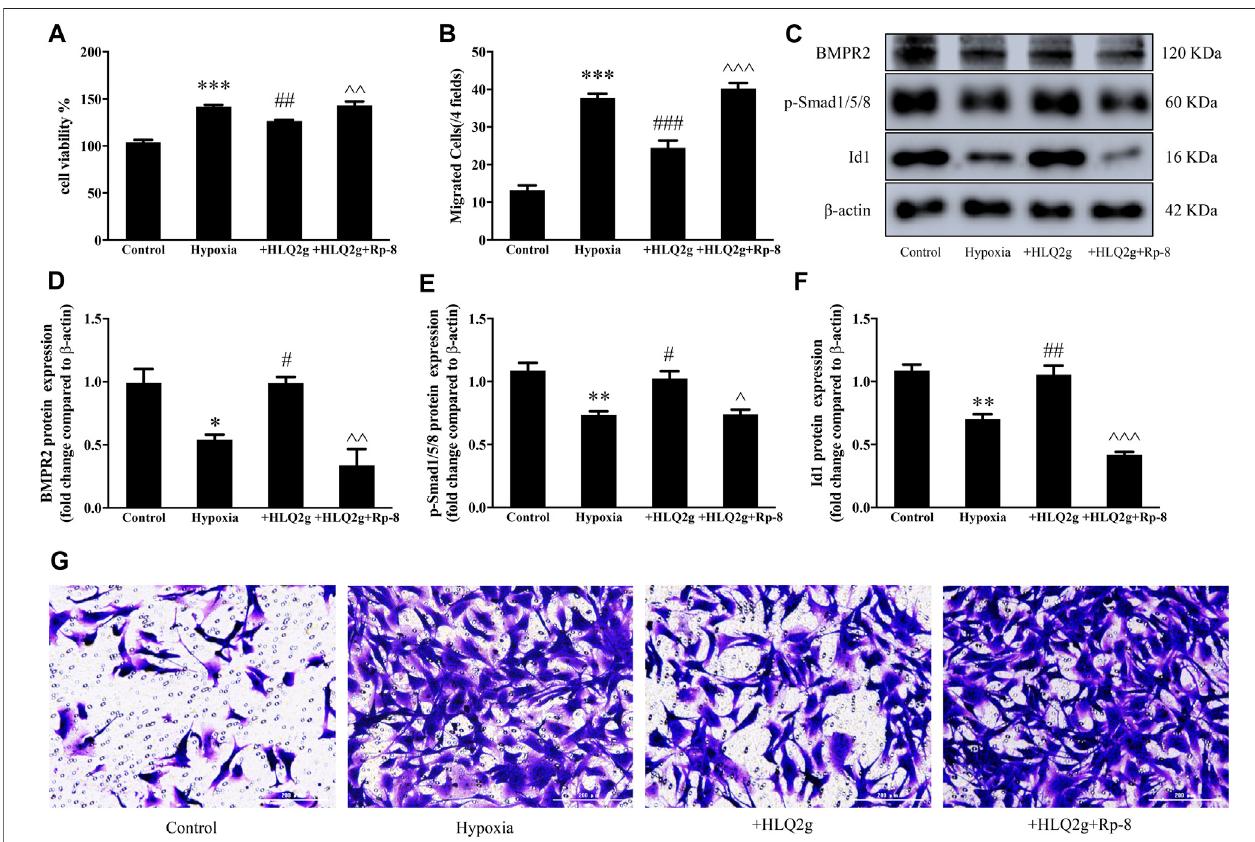
FIGURE 7 | Rp-8-Br-PET-cGMPS can block the effect of HLQ2g. (A) : CCK8 detected cell proliferation. (B, G) : Transwell test results (200 μ m). (C) : The protein expression of BMPR2, p-Smad1/5/8, and Id1 in HPASMCs determined by Westernblot. (D – F) : Quantitative analysis results of graph C. HLQ2g (1 μ M); Rp-8: Rp-8-Br- PET-cGMPS(30 μ M). Data expressed as mean ± SD, n (cid:1) 3 – 5. Vs. the control, * p < 0.05, ** p < 0.01, *** p < 0.001; vs. theHypoxia group, # p < 0.05, ## p < 0.01, ### p < 0.001; vs. the Hypoxia + HLQ2g group, ^ p < 0.05, ^^ p < 0.01, ^^^ p <